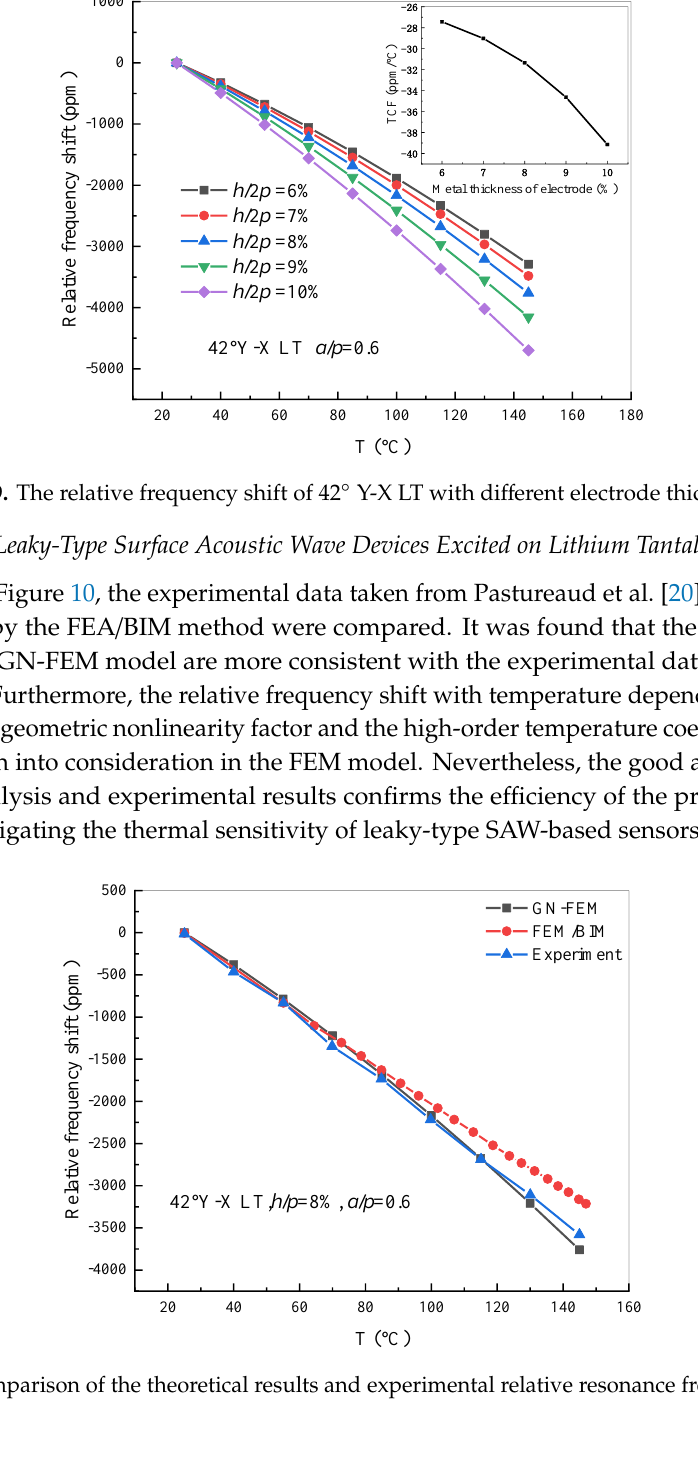
Figure 8. The relative frequency shift of 42° Y-X LT with different metallization ratios.